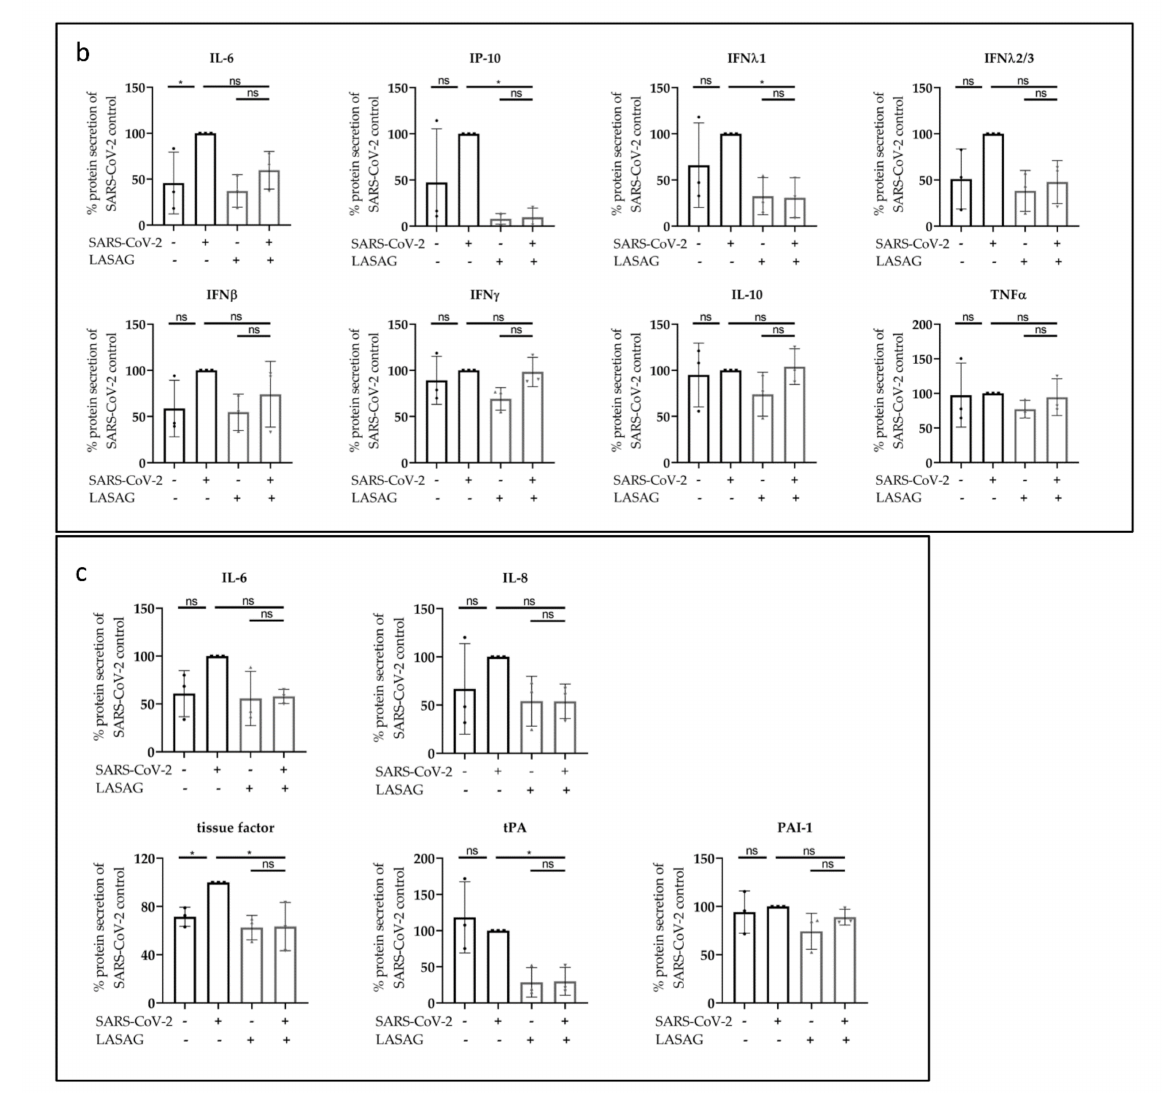
Figure 4. LASAG treatment results in the reduction in SARS-CoV-2-induced cytokine synthesis in a chip model. Both the epithelial and endothelial chambers were left untreated or were incubated with 10 mM of LASAG for 1 h. Subsequently, the chambers were left uninfected (mock) or were infected with the SARS-CoV-2 Alpha variant (isolate 5159) at 1 MOI in the absence and presence of LASAG for 3 h. After a medium change, cells were further incubated in the absence and presence of LASAG. At 28 h p.i., the analyses were conducted. ( a ) Immunofluorescence staining of the epithelial layer was performed and the SARS-CoV-2 spike protein was visualized via a spike-specific antibody and an Alexa Fluor 488-conjugated goat-anti mouse IgG antibody (green). The nuclei were stained with Hoechst 33342 (blue). The E-Cadherin of the epithelial cells was visualized by anti-E-Cadherin- specific antibody and a Cy5-conjugated goat-anti rabbit IgG antibody (red). Scale bars represent 100 µ m. ( b , c ) Different factors of supernatants of ( b ) the epithelial and ( c ) the endothelial chamber were analyzed by flow cytometry. Means ( ± SD) of three independent experiments are shown. Levels of untreated, infected samples were arbitrarily set to 100%. After normalization, ordinary one-way ANOVA followed by Dunnett’s multiple comparisons test were performed (ns, non-significant; *, p <